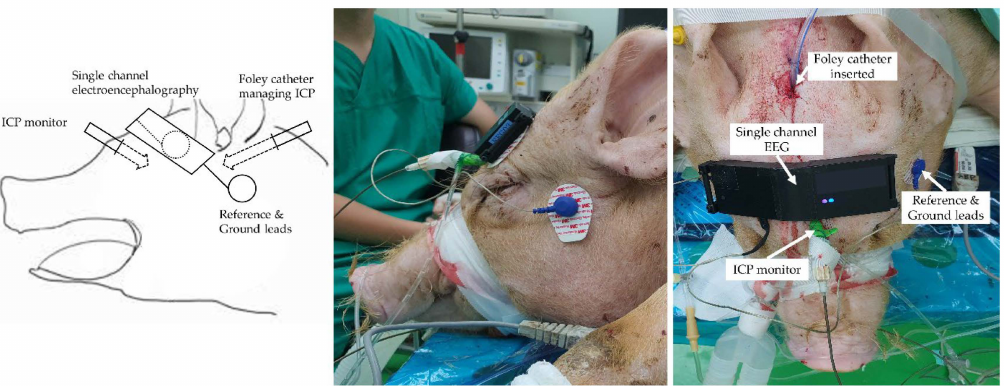
Figure 2. Attachment of single channel EEG in a porcine TBI experimental model. ICP, Intracranial pressure; EEG, Electroencephalogram; TBI, Traumatic brain